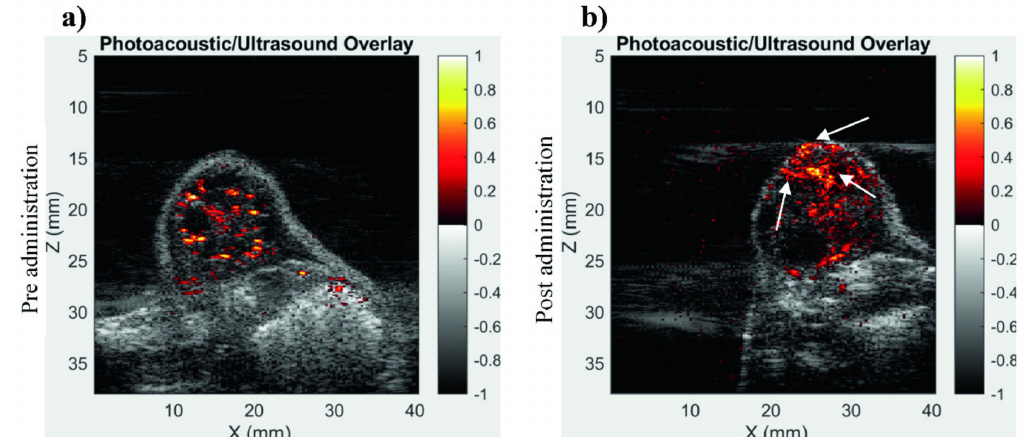
Figure 9. Contrast enhancement in LED-based PAI using exogeneous contrast agents. Combined overlay of PA and US image of subcutaneous FaDu tumor in mice before ( a ) and after ( b ) the NC dye administration. PA images were acquired using 850 nm LED light source (areas with greater contrast is shown with white arrows). Reprinted with permission from Ref. [79].